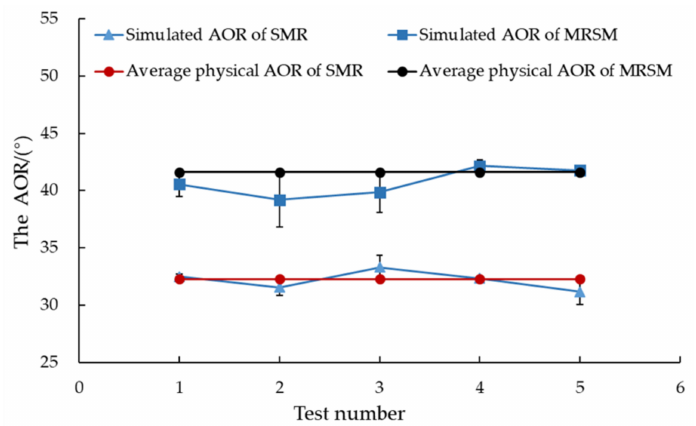
Figure 13. Comparison between the average physical and the simulation value of the AOR under the optimal parameter combination.